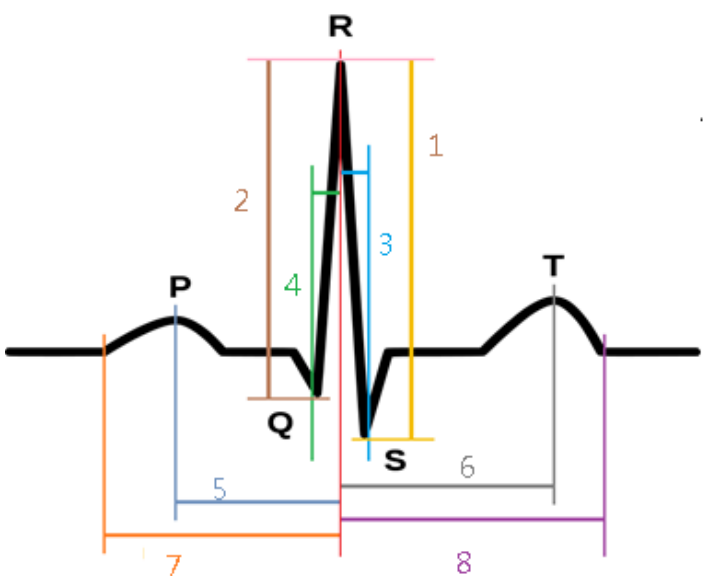
Figure 5. Eight ECG features and the PQRST points. (where ‘1’ is the amplitude difference between point R and point S; ‘2’ is the amplitude difference between point R and point Q; ‘3’ is time interval from point R to point S; ‘4’ is time interval from point Q to point R; ‘5’ is time interval from point P to point R; ‘6’ is time interval from point R to point T; ‘7’ is the time interval from the left of point P to point R; ‘8’ is time interval from point R to the right of point